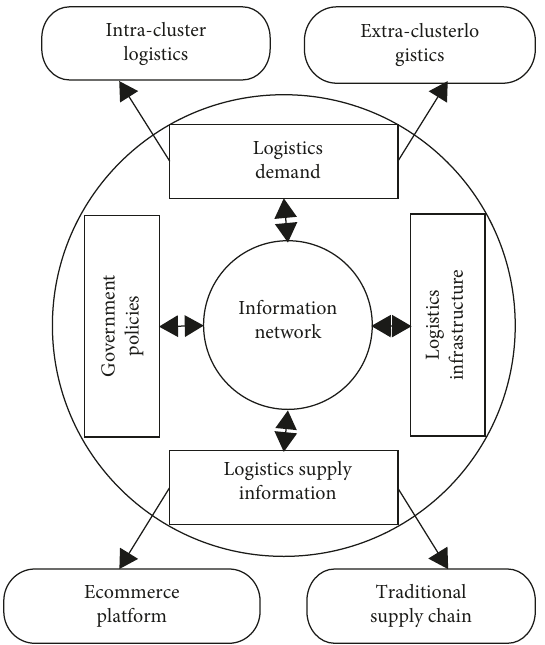
Figure 1: Radiation mechanism of city cluster logistics information